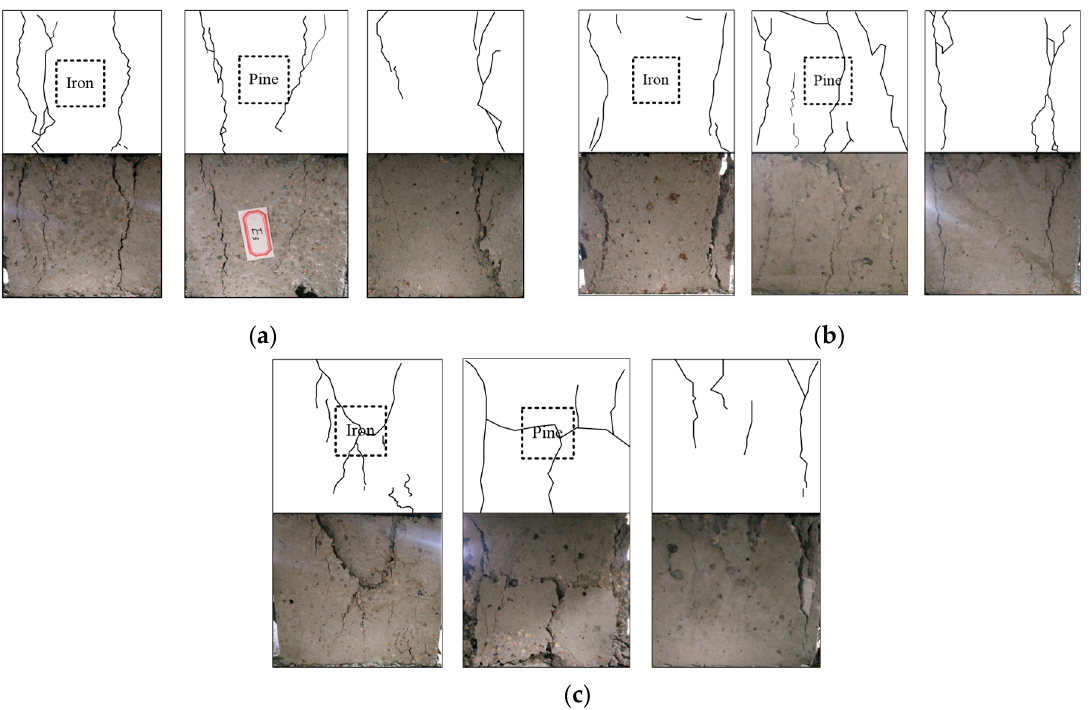
Figure 5. Illustrations (top) and photos (bottom) of cracks in sandwich specimens. ( a ) Cement–sand ratio 1:1, ( b ) cement–sand ratio 1:1.5, and ( c ) cement–sand ratio 1:2.